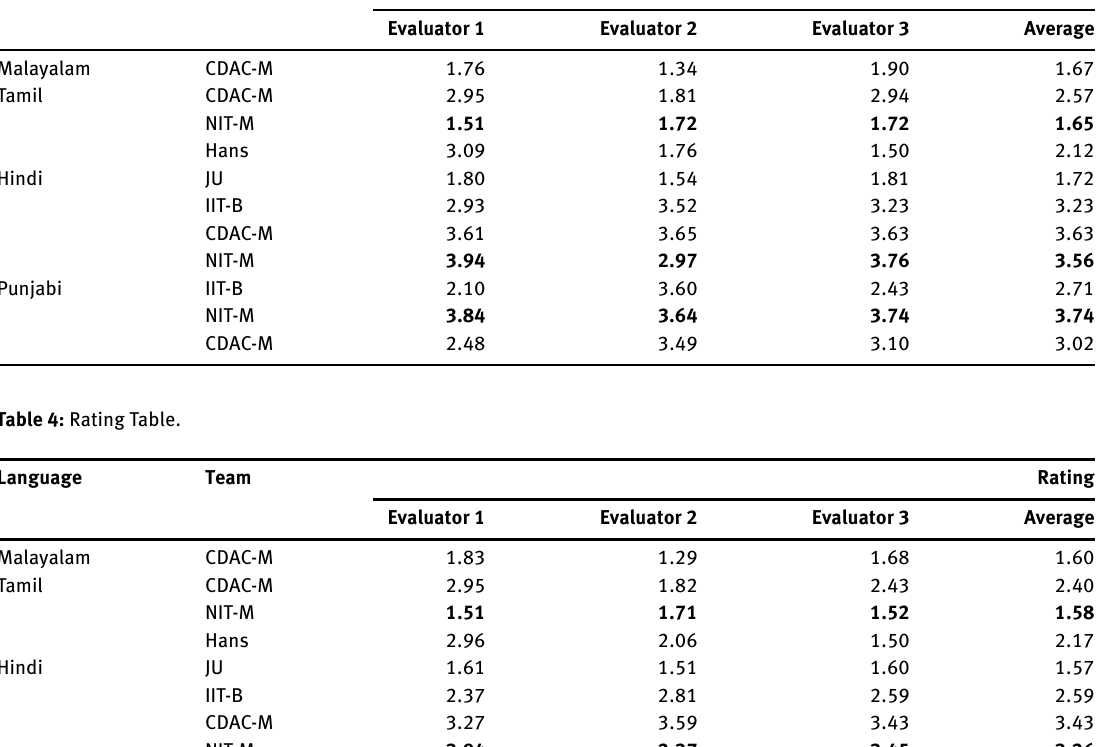
Table 3: Fluency Table. Language